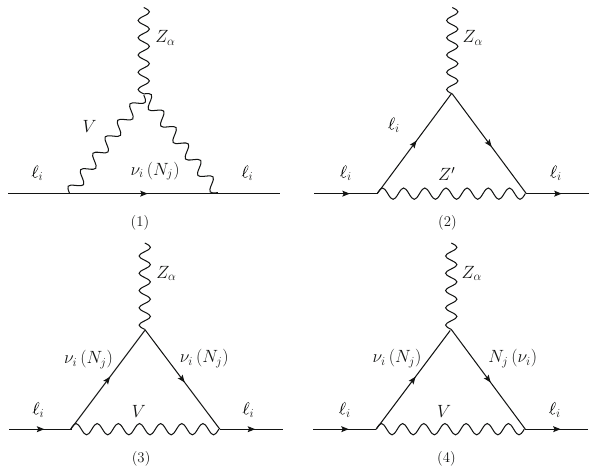
Fig. 1 Feynman diagrams that contribute to the AWMDM of charged lepton (cid:6) i at the one-loop level in the gauge sector of the SLHM. Here V can be either the W gauge boson or the new charged X gauge boson, ν i and N j stand for a SM neutrino and a new heavy one predicted by the SLHM, respectively. Notice that diagram ( 4 ) involves the non-diagonal vertex Z ¯ ν i N j